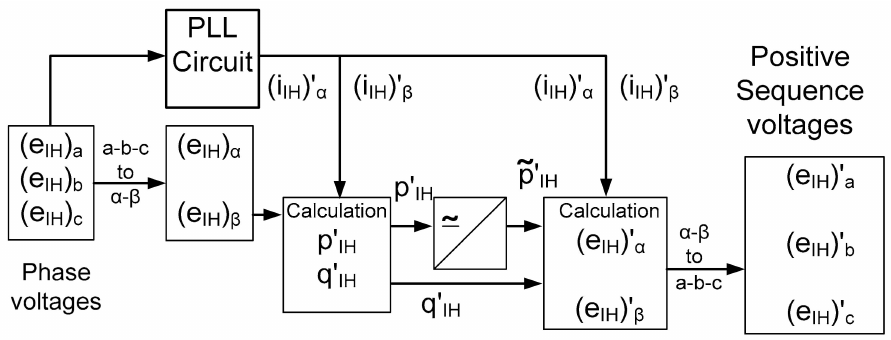
Figure 3. Proposed structure of a positive sequence voltage